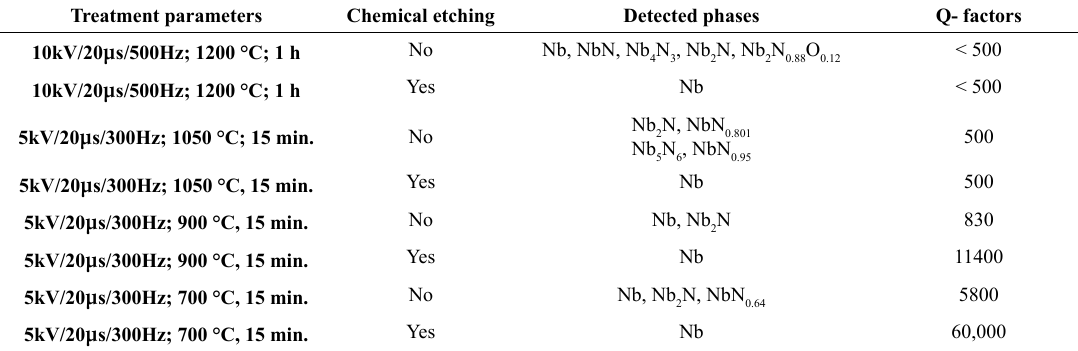
Table 1. Correlation between ion implantation parameters and respective Q-factors of niobium reentrant cavities, showing the phases detected by XRD and whether the chemical attack was or not performed. The experimental condition that changed compared to the previous treatment is underligned. Treatment